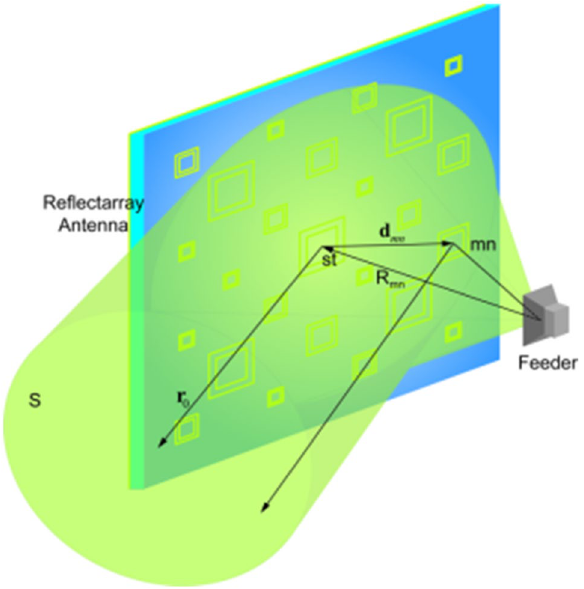
Figure 1. Schematic diagram of the reflectarray